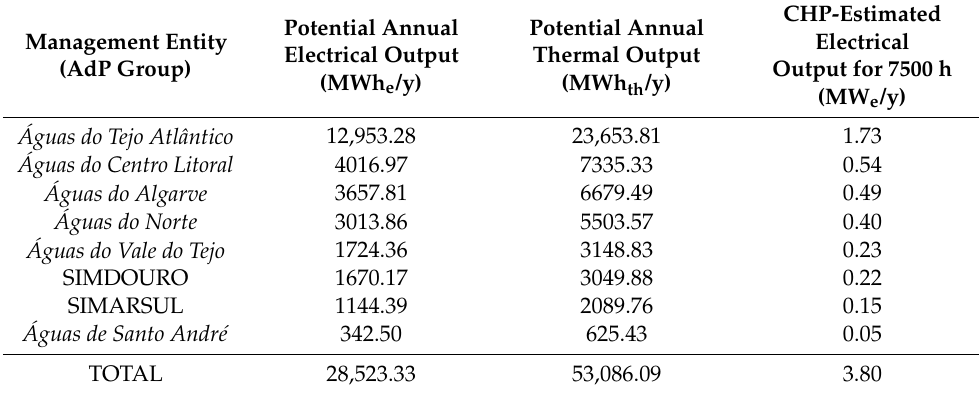
Table 4. Estimated heat and power production from dewatered-sludge gasification for different WWTPs from the AdP